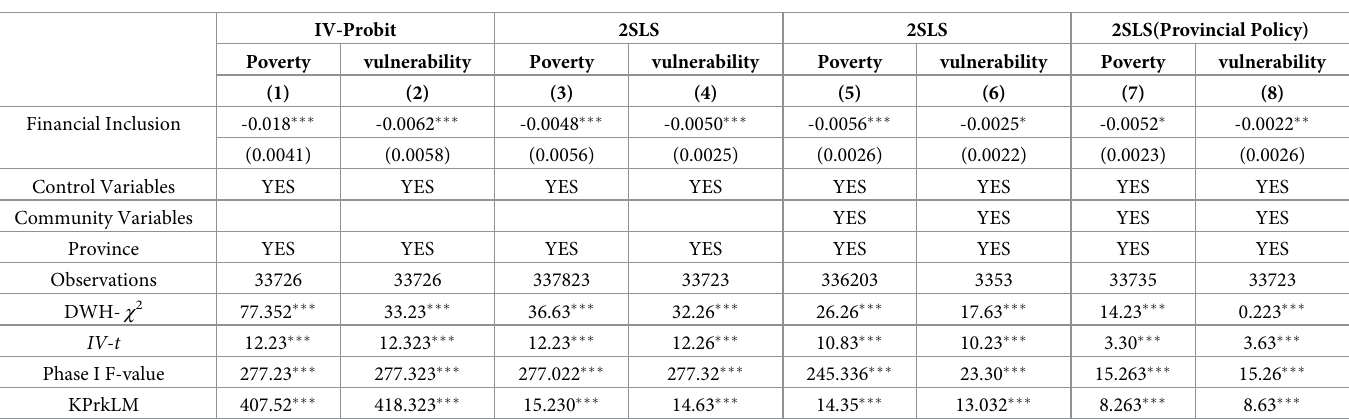
Table 5. Estimation results of instrumental